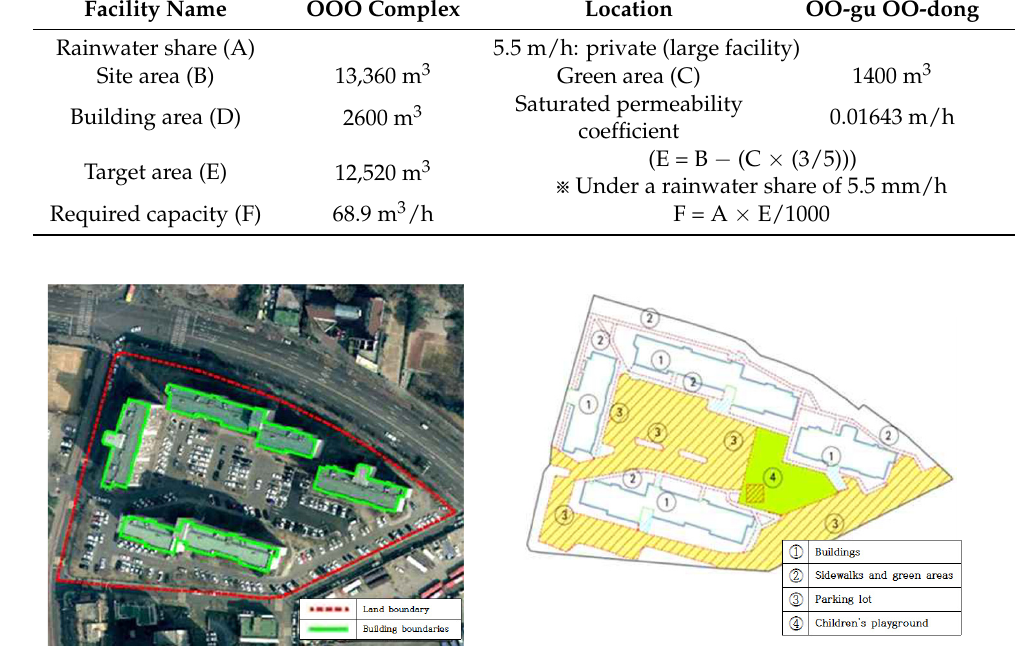
Figure 13. Status of the target site.